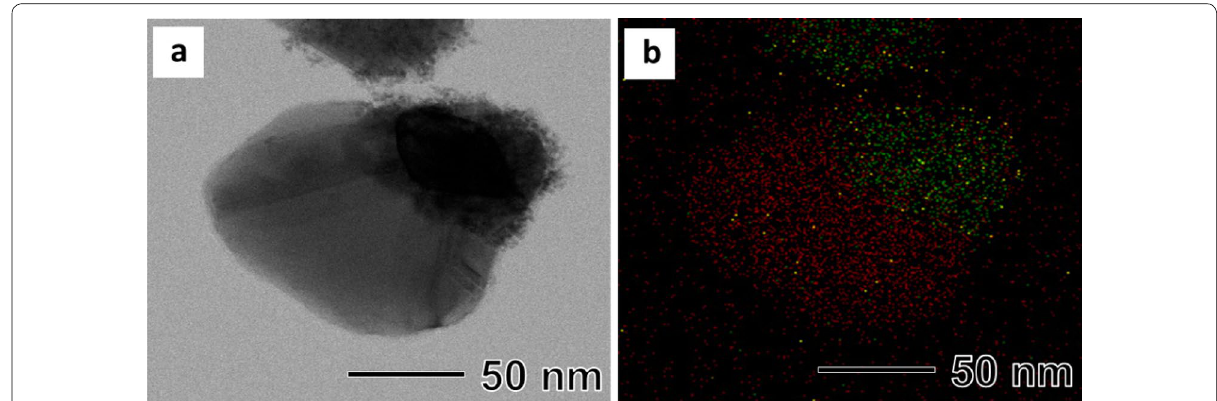
Fig. 4 a TEM image and b EDS‑mapping image of metallic elements distribution in Ag–Cu–Pt